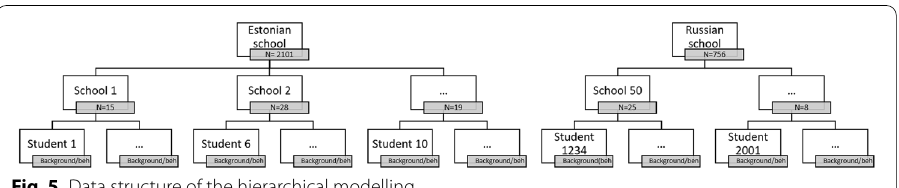
Fig. 5 Data structure of the hierarchical